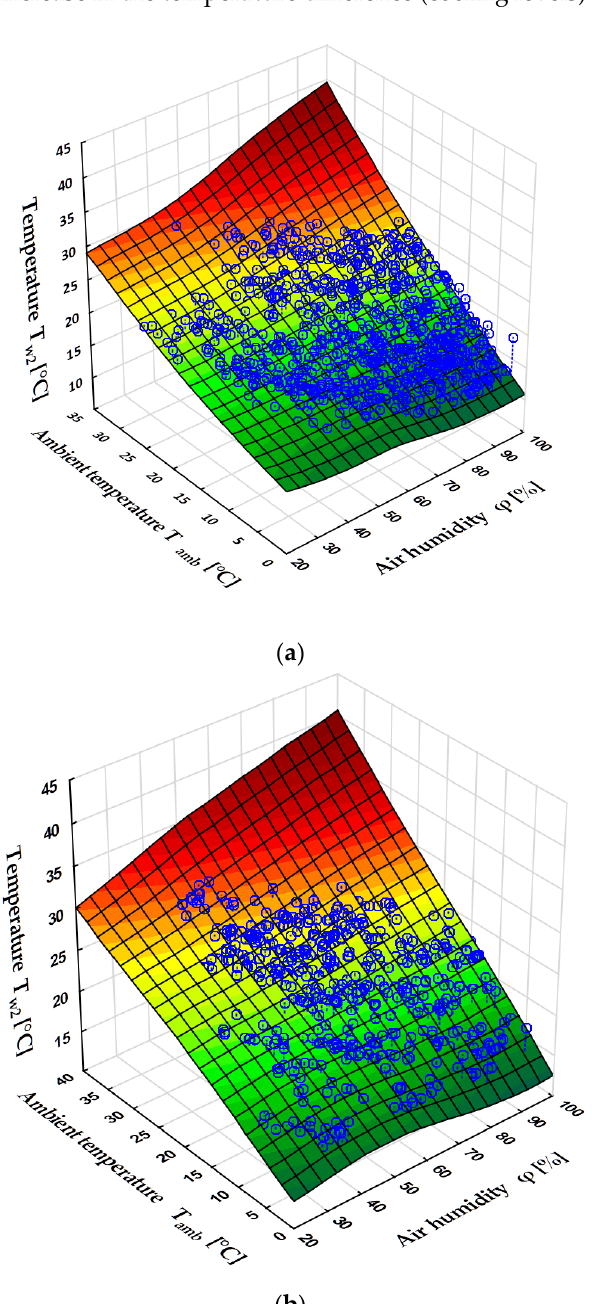
Figure 2. The relationship between ambient temperature T amb at the cooling tower outlet and cooled water temperature 𝑇 𝑤2 and air humidity 𝜑 , ( a ) for the power range of 390 − 410 MWe , ( b ) for the power range 890 − 910 MWe of power unit 5. Source: own elaboration (Statistica software).